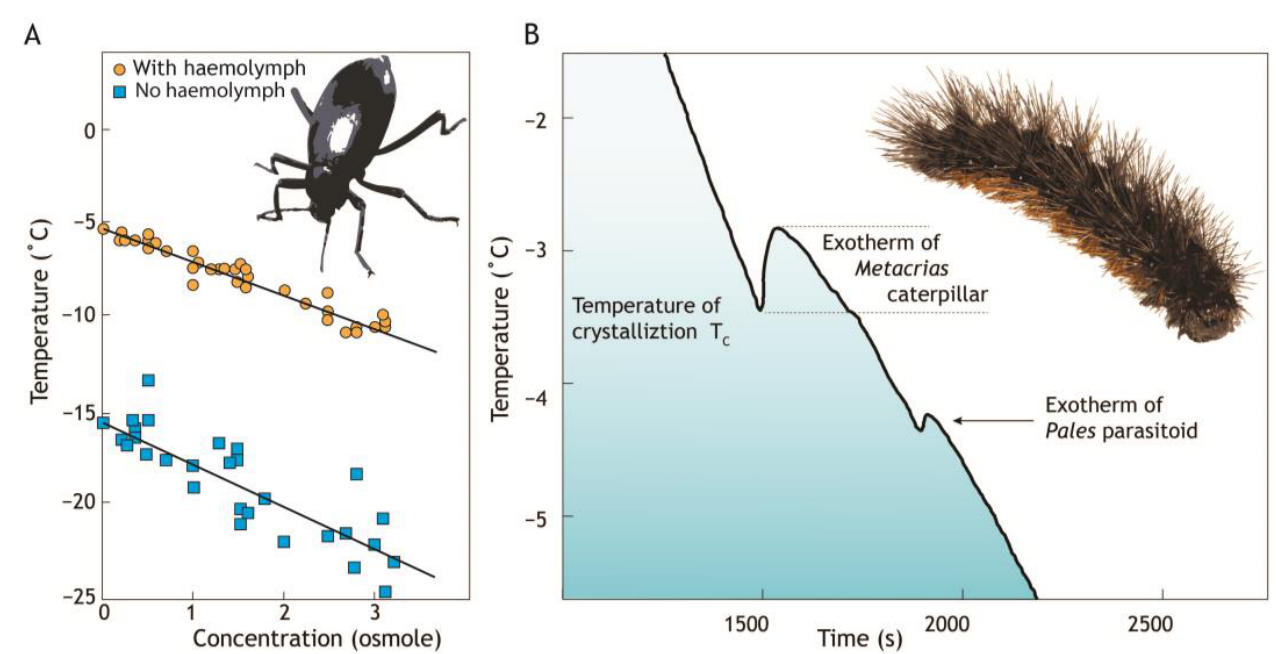
Figure 2. ( A ) The temperature of water crystallization is suppressed (freezing point depression) by increasing concentration of solutes such as sugars and salts (blue symbols). However, addition of haemolymph from Eleodes blanchardi beetles (orange symbols) [21,22] elevates this by about 10 °C. ( B ) The release of energy (exotherm) that occurs when water changes from the liquid to solid state (freezing) marks the temperature of crystallization (T C ) or ‘supercooling point’. Detection of this exotherm in an experimental setting shows that ice has formed in the subject. In this example the caterpillar of the alpine tiger moth ( Metacrias huttoni ) has a higher (warmer) temperature of crystallization than its internal tachinid parasite, Pales sp. [23].